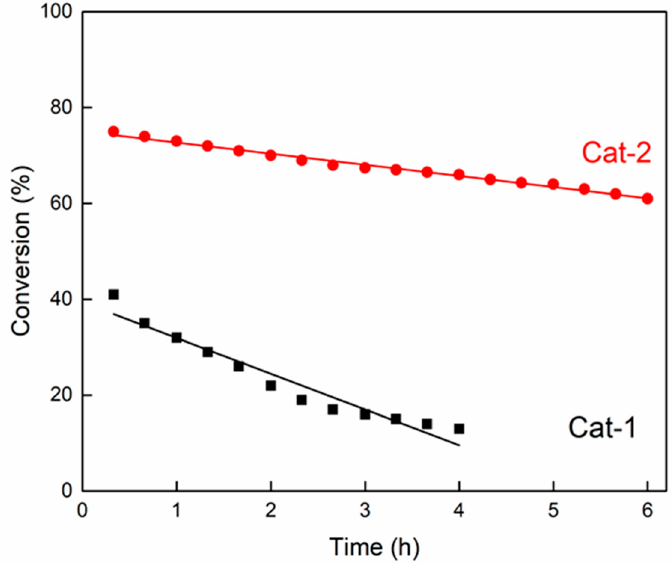
Figure 4. Methane conversions over 6 h (1023 K, 1 bar, and gas velocity 18 K mL g − 1 h − 1 ).